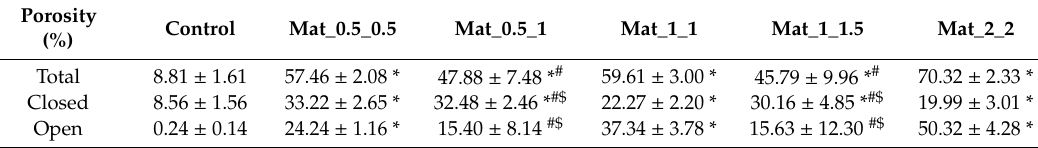
Table 2. Porosity of the biomaterials determined by micro-CT